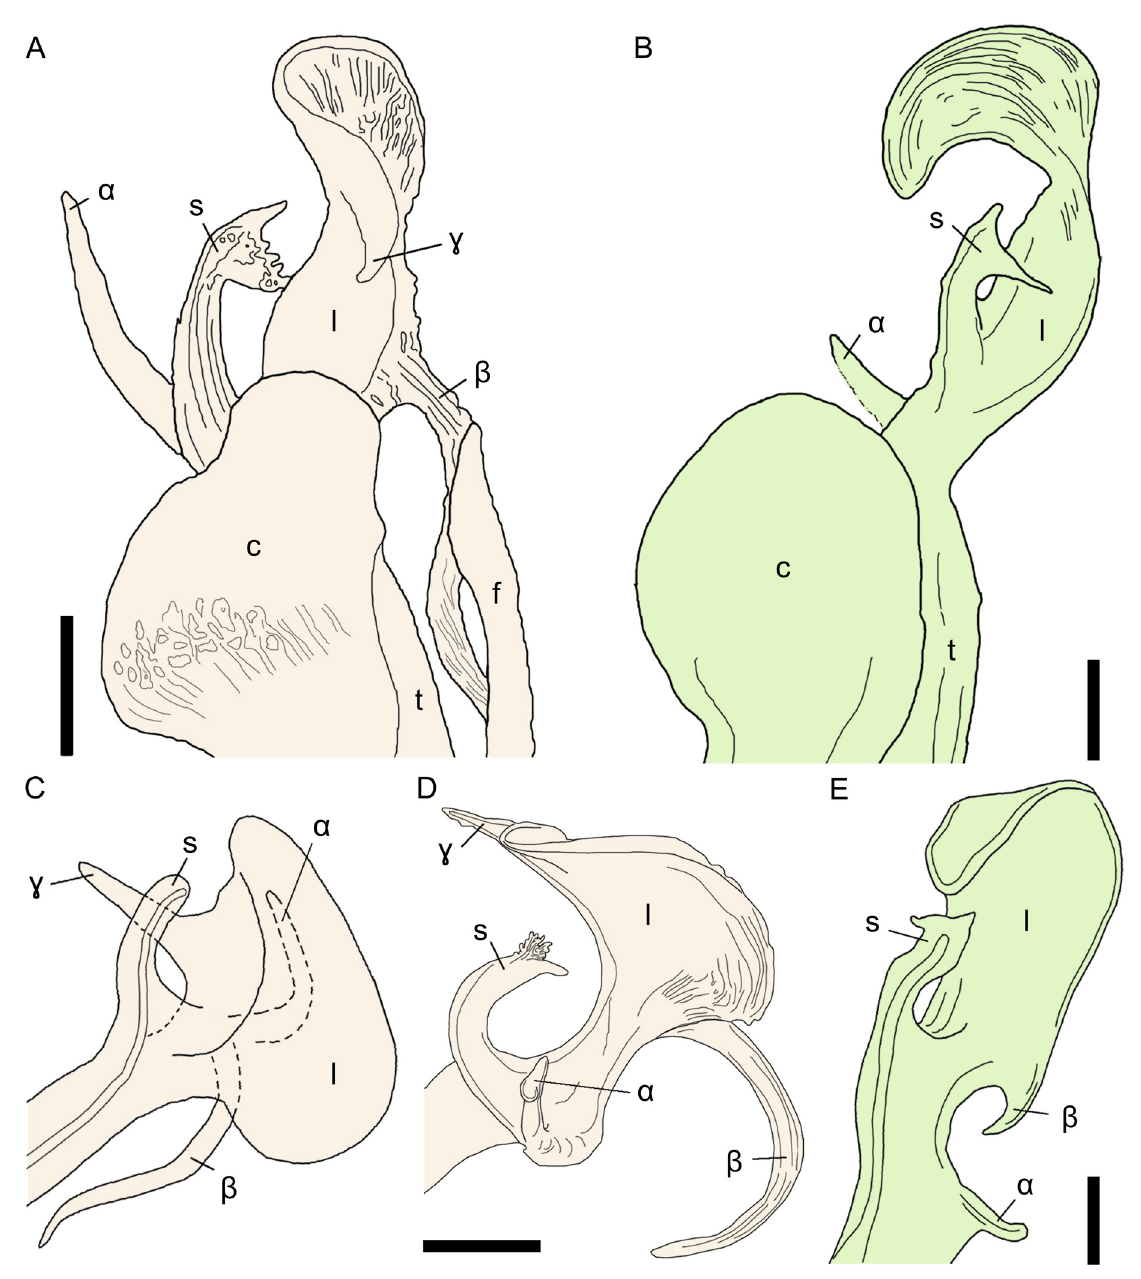
Fig. 6. Telopodite and gonocoxite of Lusitanipus alternans and Lusitanipus xanin sp. nov. A . Distal part of gonopod of Lusitanipus alternans in anterior view , redrawn after Reboleira & Enghoff (2015). B . Distal part of gonopod of Lusitanipus xanin sp. nov. in anterior view. C . Tip of telopodite of Lusitanipus alternans in lateral view, redrawn after Verhoeff (1900) (original without scale bar). D. ip of telopodite of Lusitanipus alternans in ventrolateral view, redrawn after a SEM photograph by Reboleira & Enghoff (2015). E . Tip of telopodite of Lusitanipus xanin sp. nov. in lateral view. Scale bars = 0.1 mm. Abbreviations: α, β and γ = processes of telopodite; c = gonocoxite; f = pseudoflagellum (or hornflagellum); l = lamella; s = solenomerite; t =